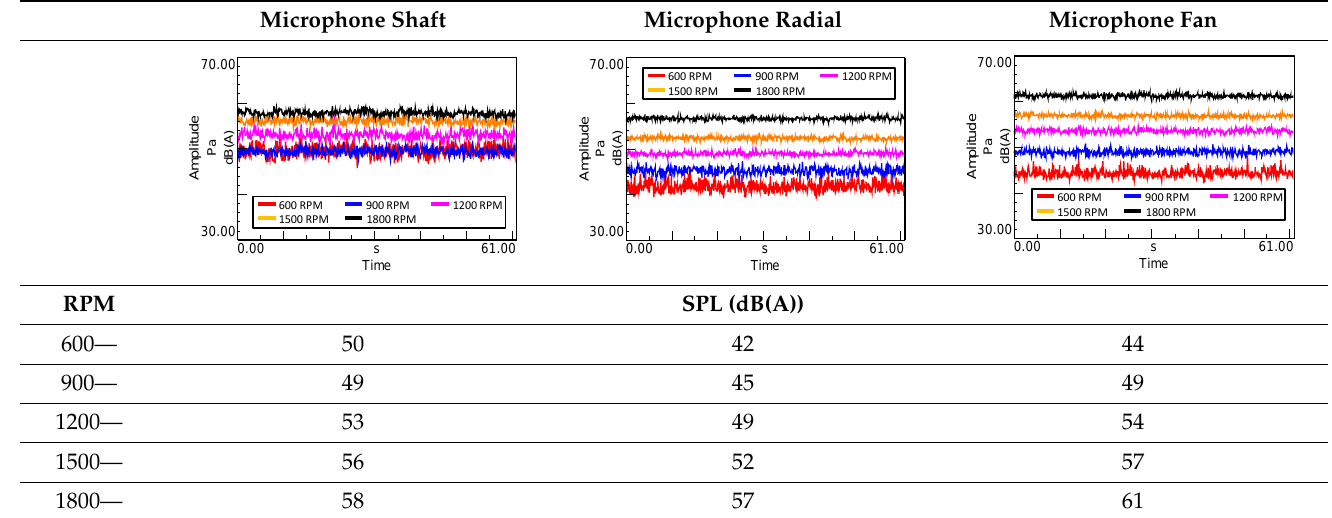
Figure 12. Zoomed-in acoustic auto-power spectrum from fan-side microphone. Table 1. Overall sound pressure levels.